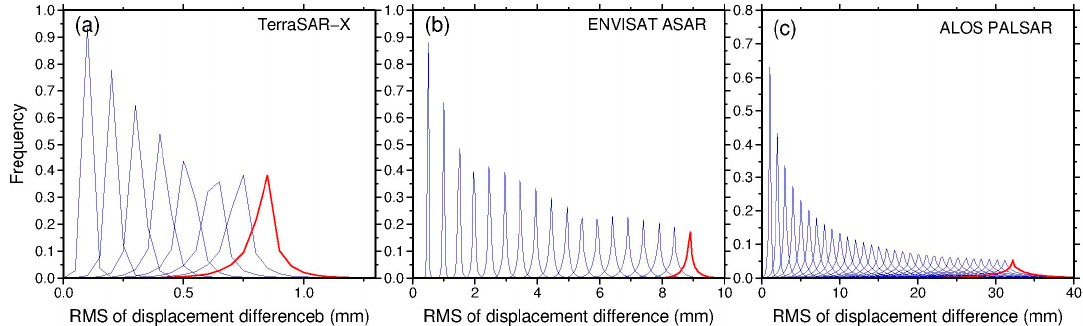
Figure 6. Histograms of deformation time-series RMSE between h_ratio > 1 and h_ratio = 1 for: X band ( a ); C band ( b ); and L band ( c ). Blue solid lines represent the deformation time-series RMSE of each case. Red solid lines represent the time-series deformation RMSE histogram when the significance test of deformation rate difference is firstly passed for each platform.